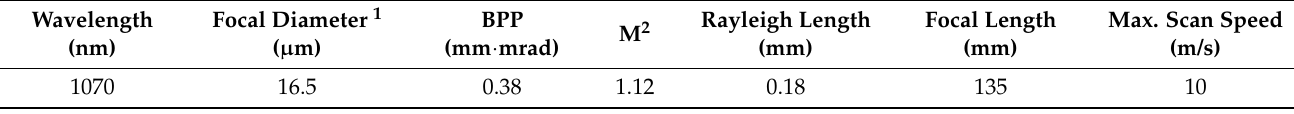
Table 2. Technical data of the laser and scanning system.